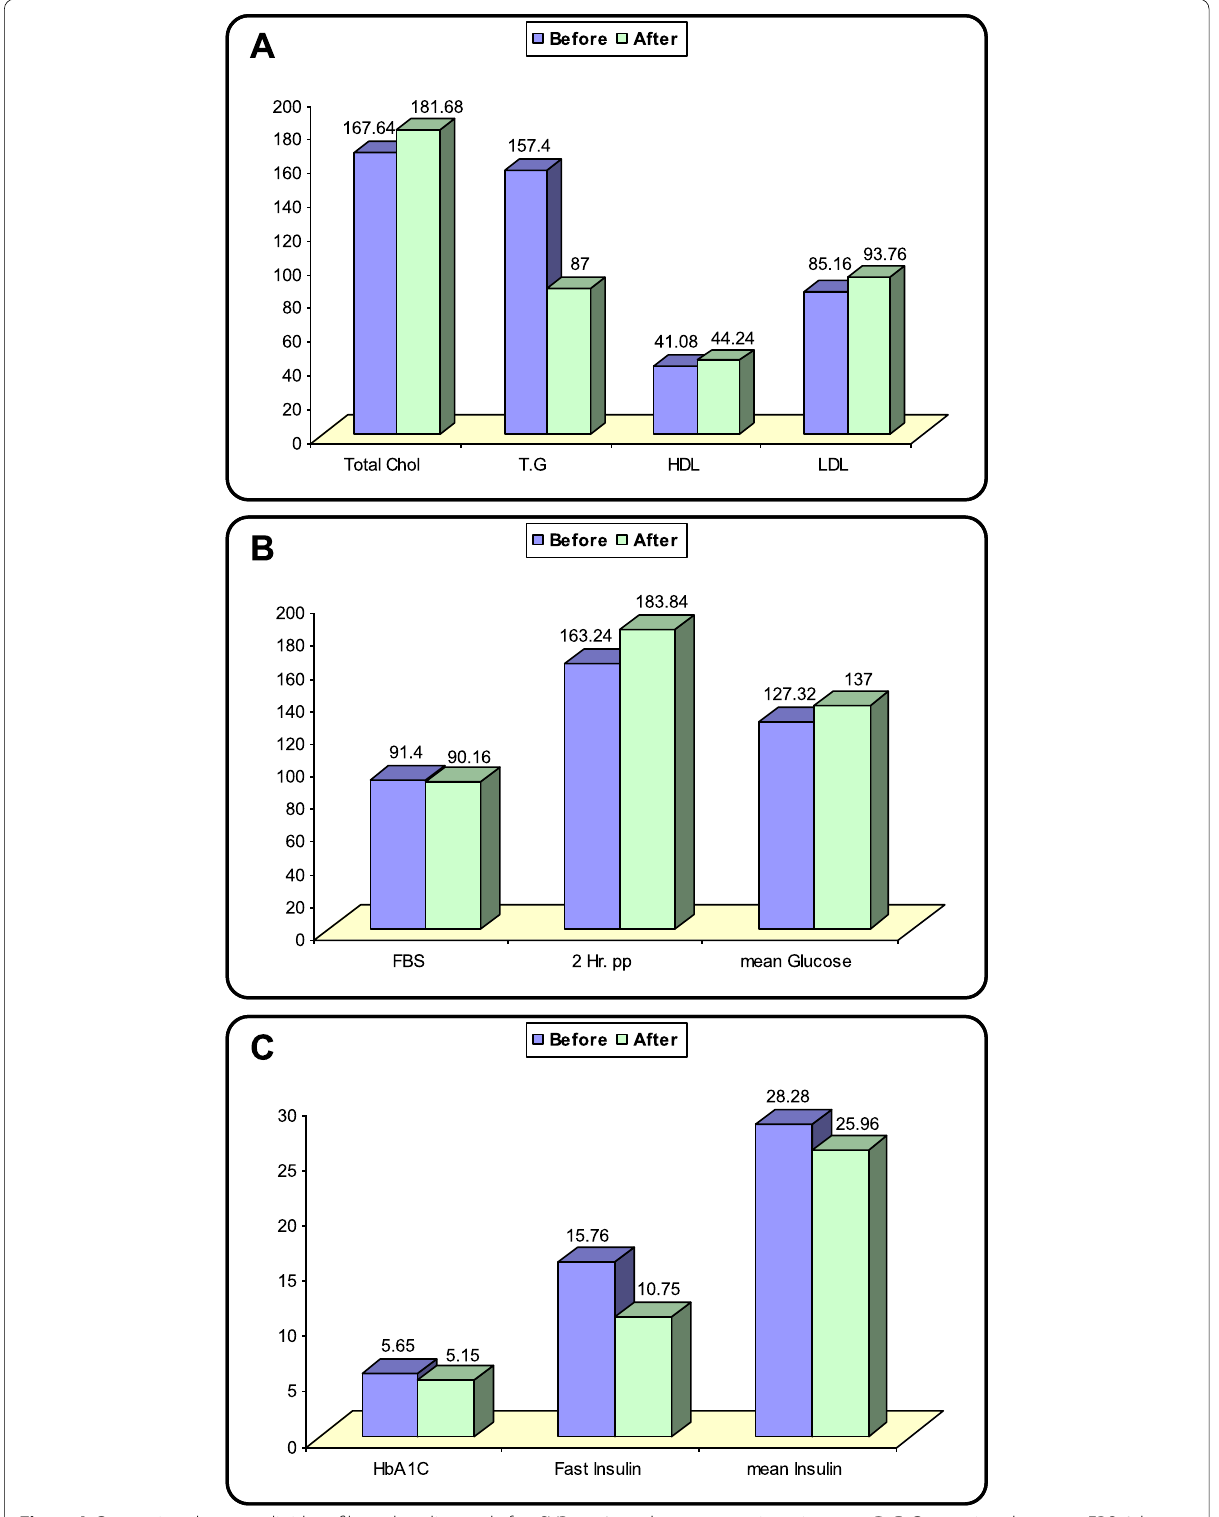
Fig. 5 A Comparison between lipid profiles at baseline and after SVR at 12 weeks among patients in group D. B Comparison between FBS, 2‑h postprandial blood glucose, and mean glucose levels at baseline and after SVR at 12 weeks among patients in group D. C Comparison between HbA1C, fasting insulin, and mean insulin levels at baseline and after SVR at 12 weeks among patients in group